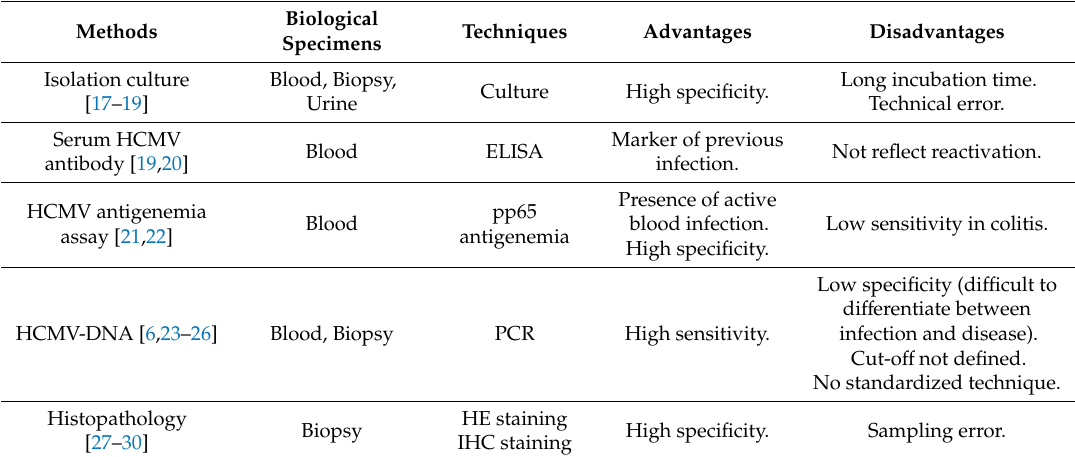
Table 1. Diagnostic tests for detecting HCMV infection. Each test has its own advantages and